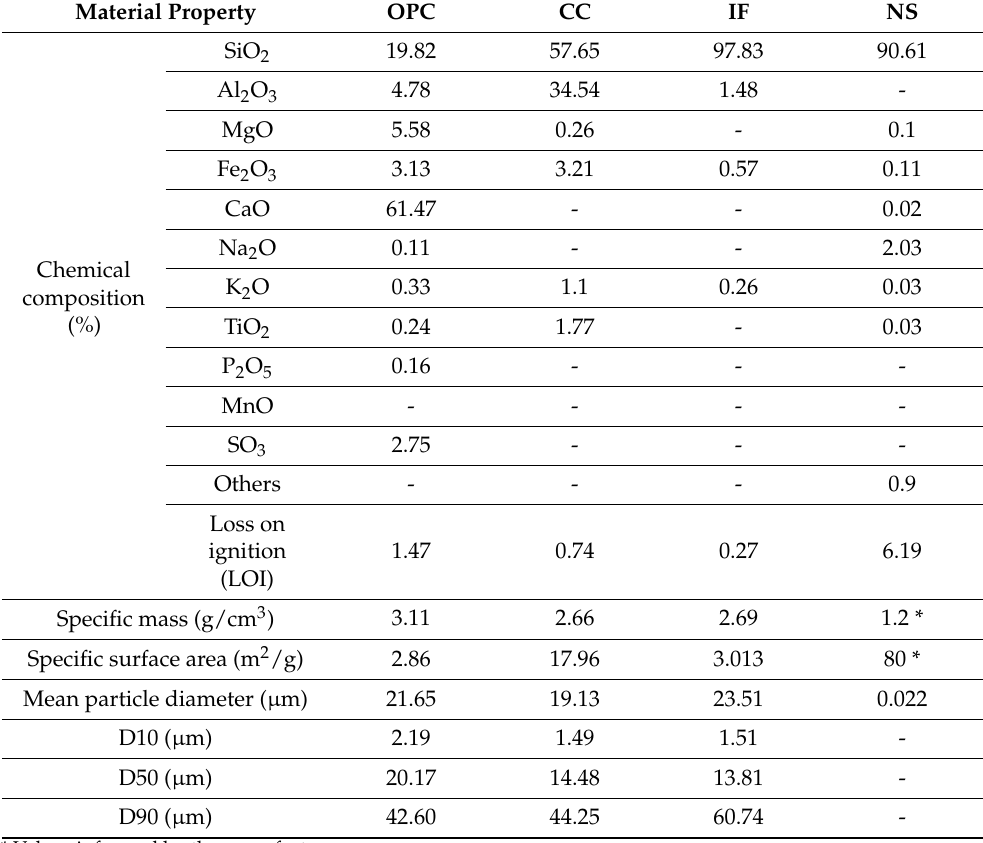
Table 1. Chemical and physical properties of OPC, CC, IF, and